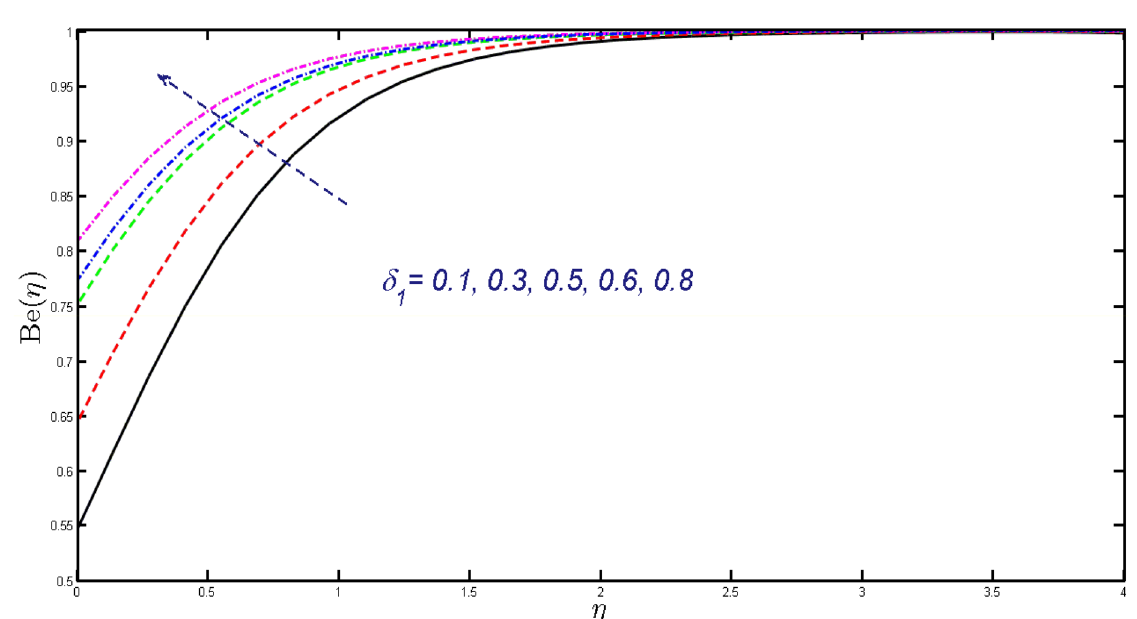
Figure 22. Field of Bejan number for δ 1